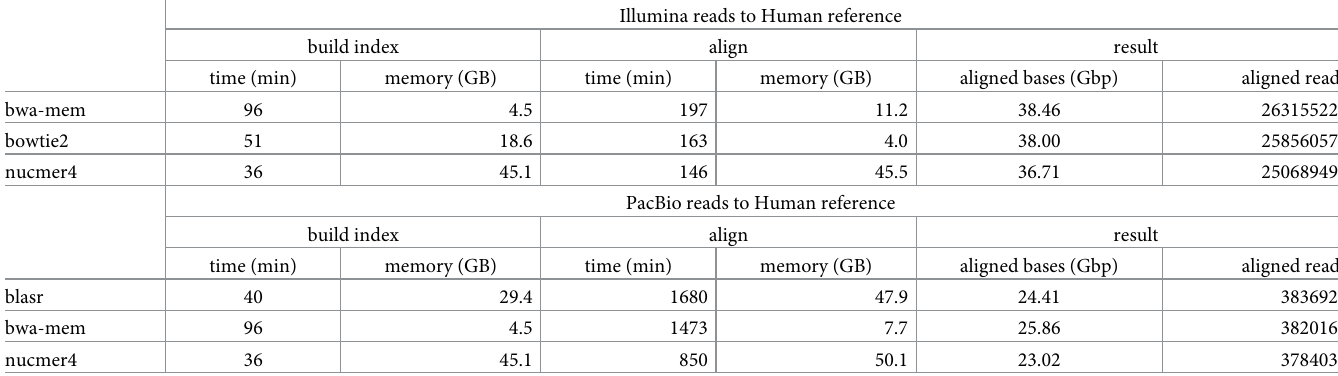
Table 6. Timing and memory usage to align Illumina and PacBio reads to human